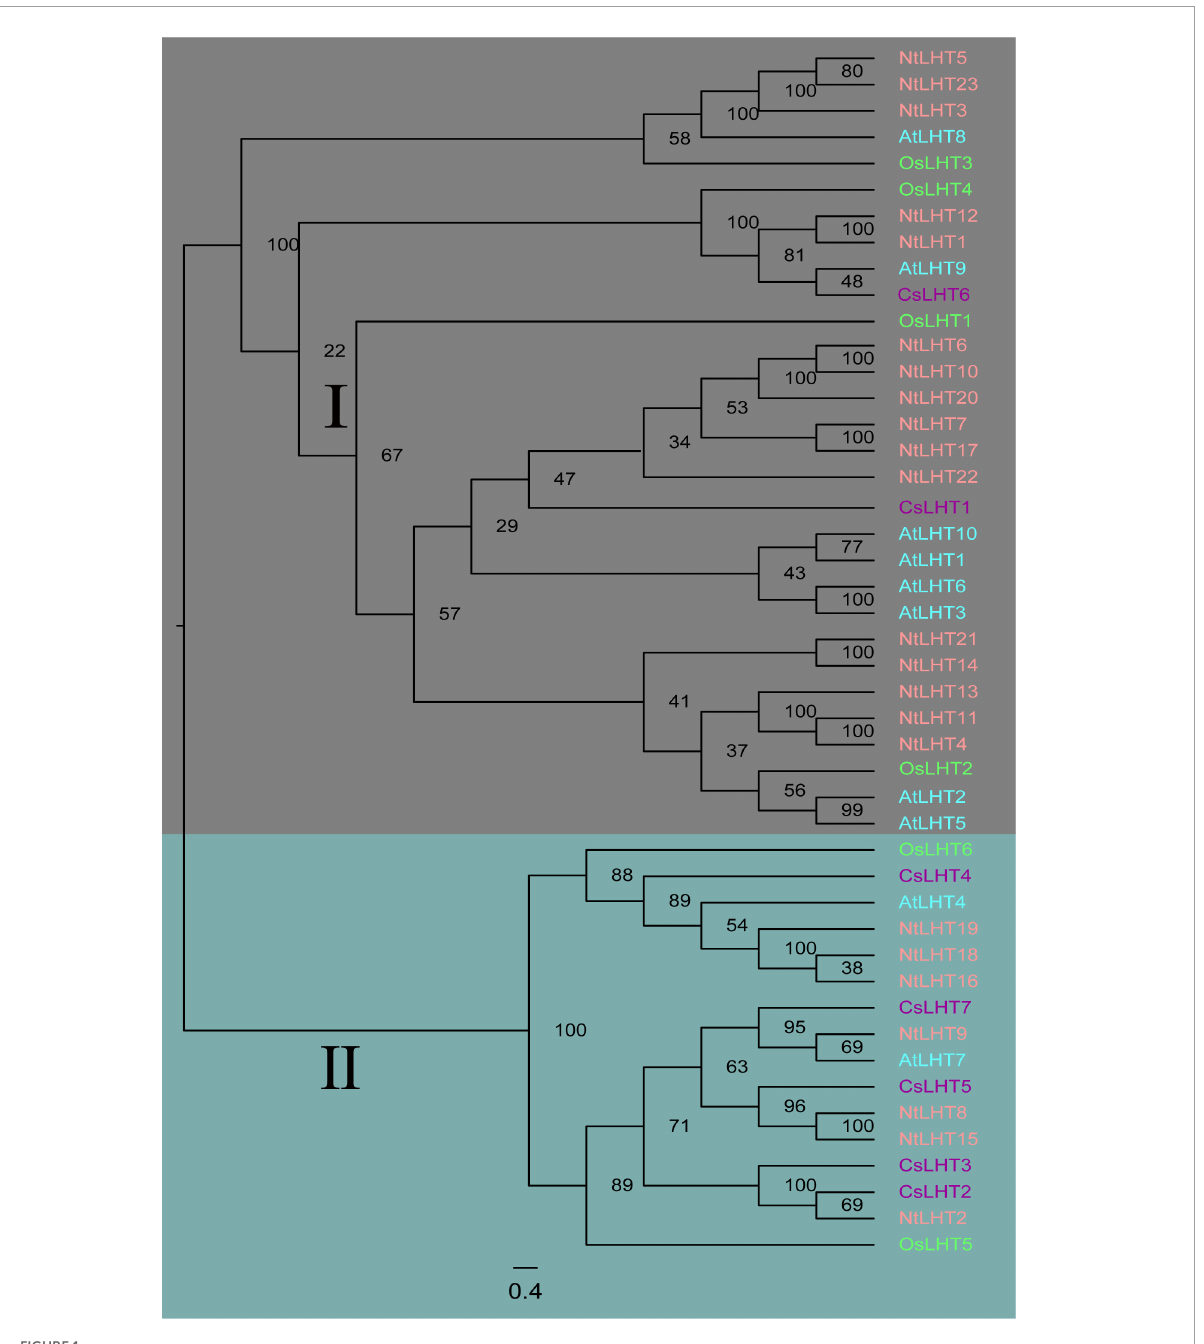
FIGURE1 Phylogenetic relationship of LHT proteins from tobacco, tea, Arabidopsis , and rice. The LHT proteins were divided into two subgroups (marked as I and II), and distinguished by different colors: NtLHT labeled in pink, CsLHT labeled in purple, AtLHT labeled in cyan, and OsLHT labeled in